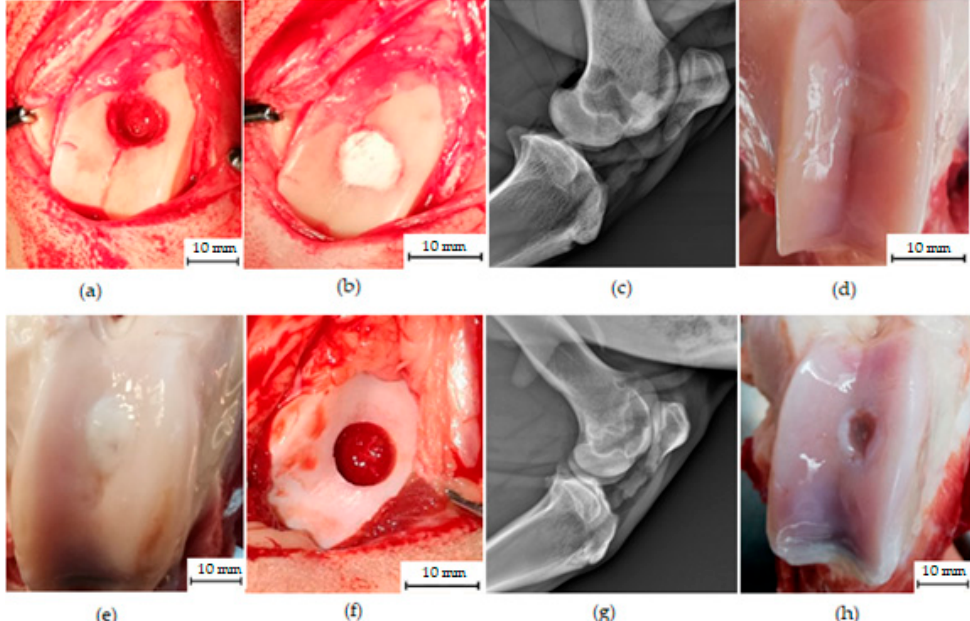
Figure 2. Gross appearance of the treated osteochondral defect ( a – e ) and untreated osteochondral defect ( f – h ) of the femoral trochlea in sheep. ( a , b ) The created defect of diameter 8 mm was filled by biomaterial CAL. ( c ) The absence of bone fractures and arthropathy was validated by X ‐ ray. (d ) At 6 months post ‐ operation, the treated defect was covered by the consistent, smooth, glistening hyaline ‐ like tissue indistinguishable from the adjacent native cartilage; however, the defect was still visible macroscopically and a small depression was present at the edge of the defect. ( e ) The defect treated with C biomaterial. ( f – h ) The same osteochondral defect was created in the untreated group. It was repaired with fiber ‐ like tissue, leaving an irregular surface and a large depression in the centre of the defect. No macroscopic signs of inflammation were found within the joint cavities.